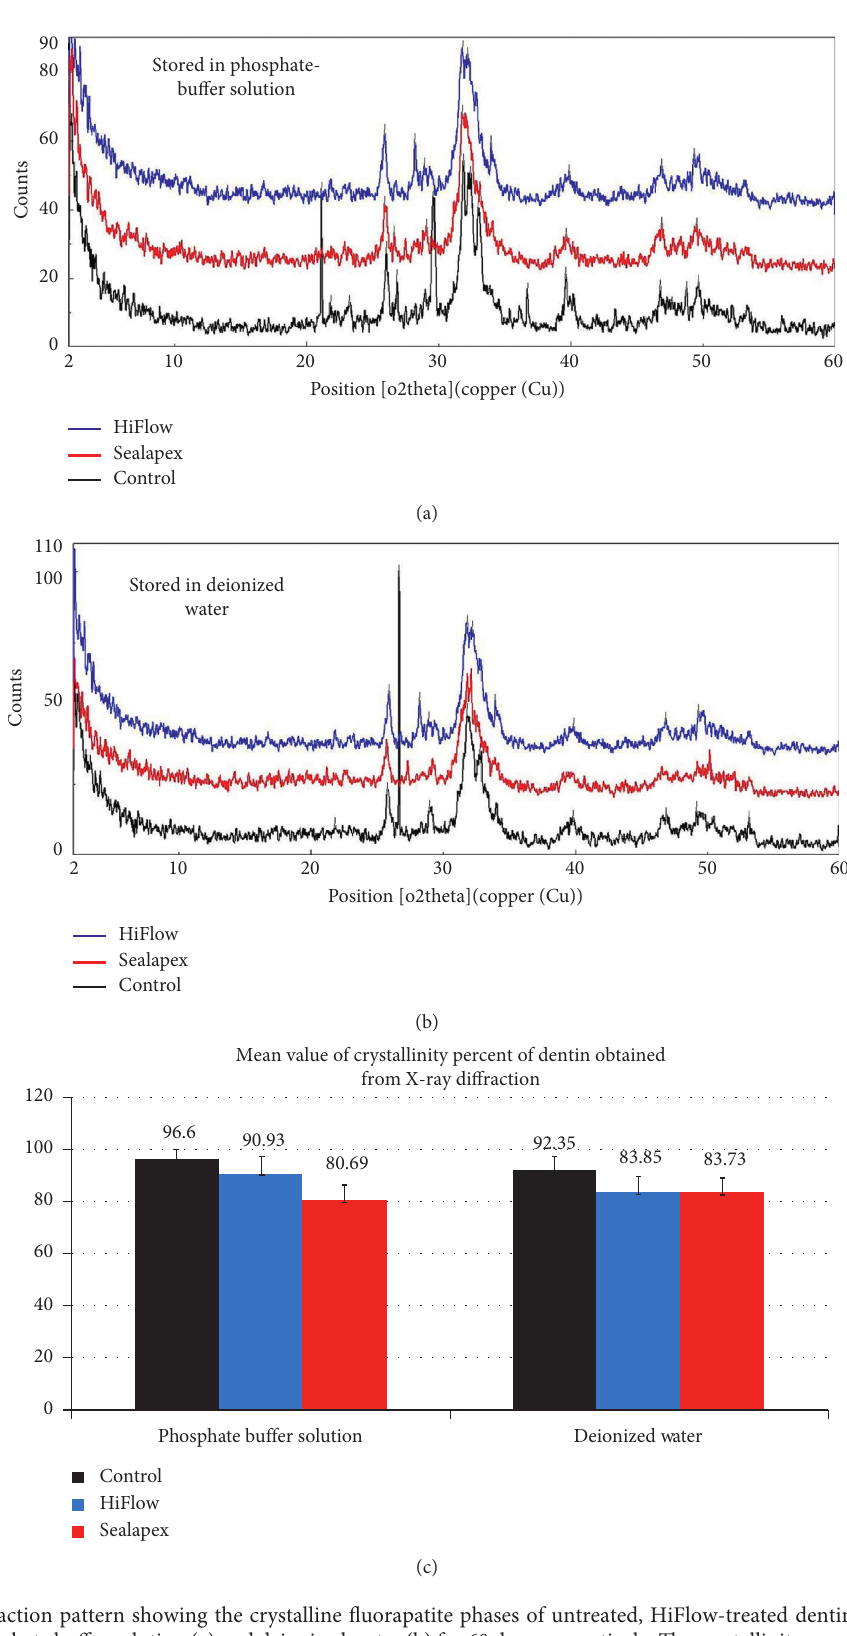
Figure 4: X-ray diffraction pattern showing the crystalline fluorapatite phases of untreated, HiFlow-treated dentin and Sealapex-treated dentin, stored in phosphate buffer solution (a) and deionized water (b) for 60 days, respectively. The crystallinity percent was decreased with tested sealers